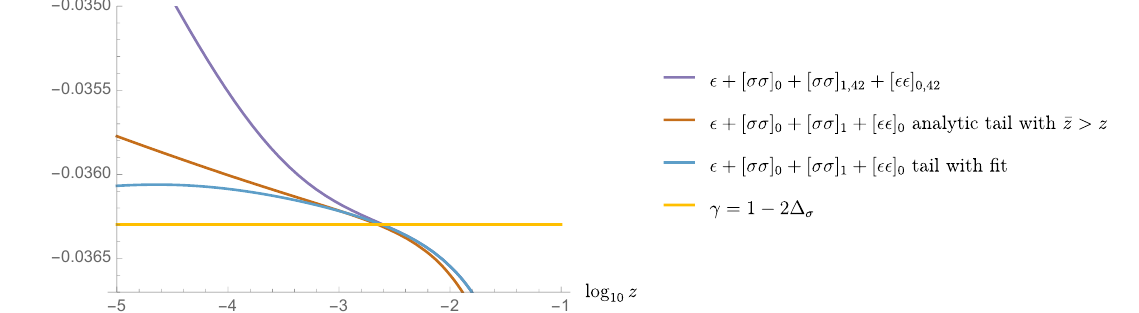
(cid:16) error from deviation from flatness and differences between two tails